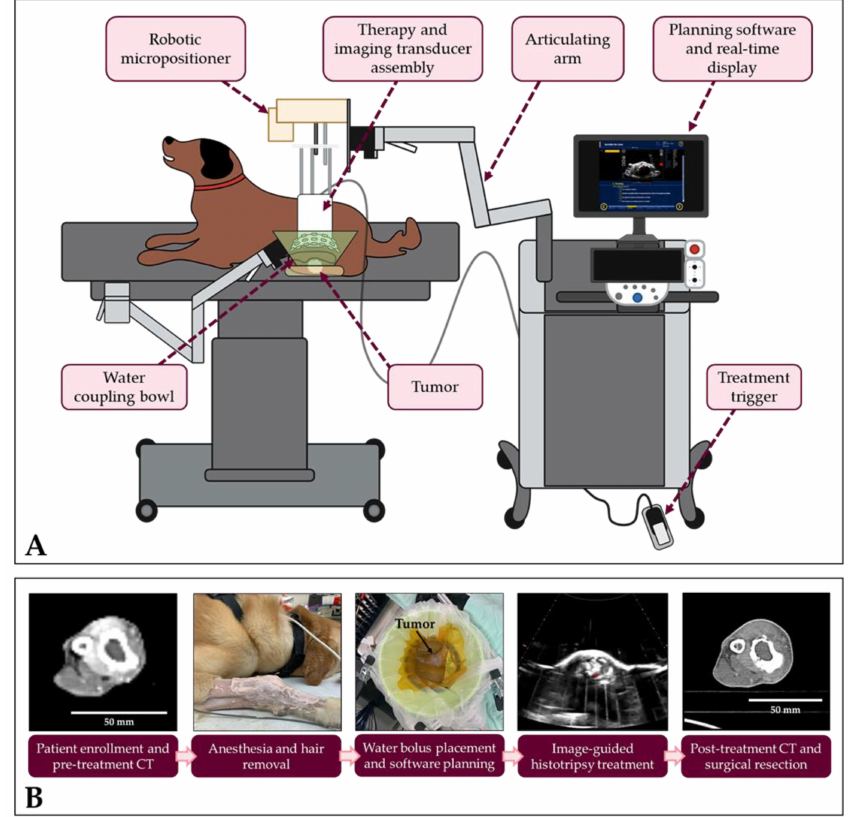
Figure 1. ( A ) Experimental histotripsy set-up. A robotic micro-positioner was connected to an articulating arm to support the therapy and imaging transducers and submerged in a degassed water bowl coupled to the patient’s tumor. ( B ) Study workflow. Patient-specific treatment plans were developing using pre-treatment imaging assessments. Before treatment, patients were anesthetized, and the hair overlying the treatment area was removed. Automated histotripsy treatments were conducted using custom treatment planning software and monitored in real-time using ultrasound imaging. One day after treatment, post-treatment CT scans were collected before limb amputation. Figure 1A was created in part with